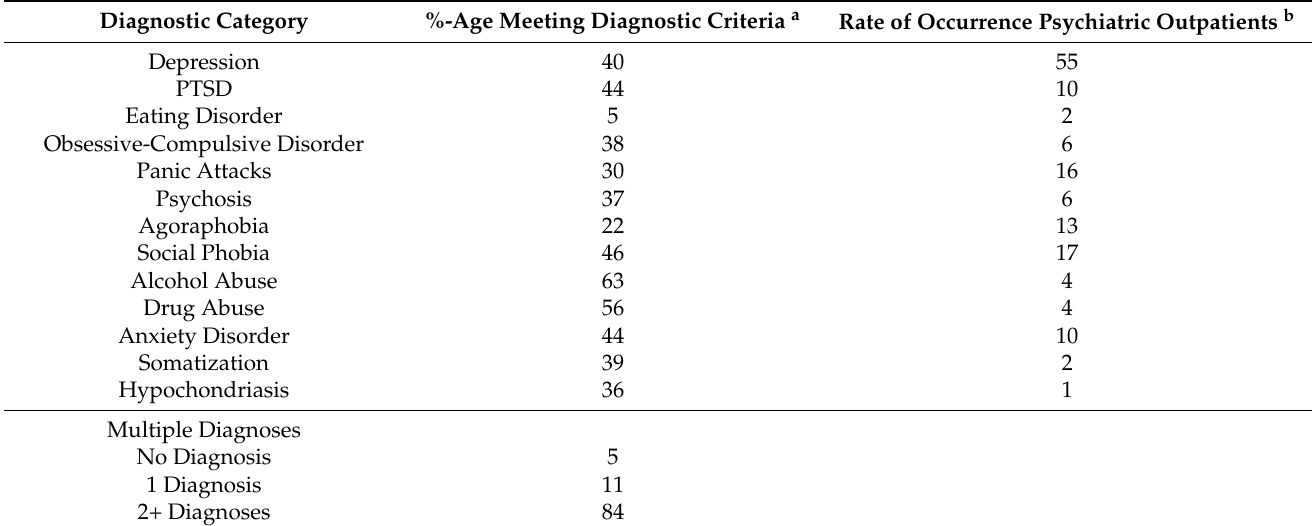
Table 1. Results of the Psychiatric Diagnostic Screening Questionnaire Obtained at Time